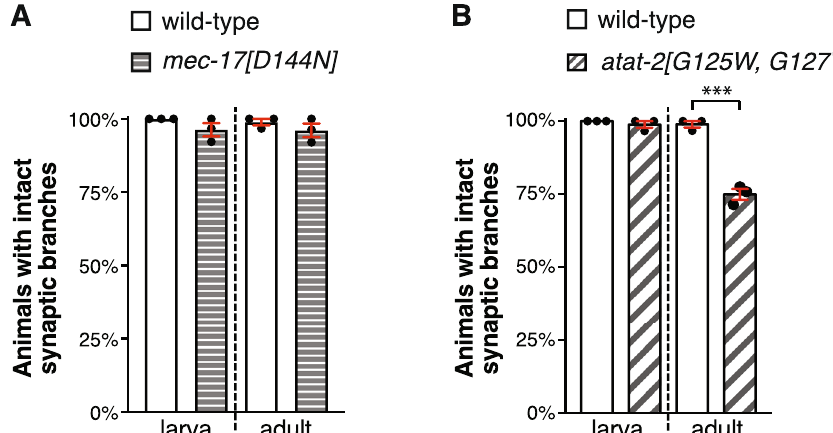
Figure 3. MEC-17 and ATAT-2 function largely independently from their acetyltransferase domains in maintaining synaptic branch stability. ( a ) Quantification of the number of animals with intact synaptic branches in mec-17[D144N] and ( b ) atat-2[G125W, G127W] animals compared to wild-type. Bars show mean ± SE; symbols show the mean of 3-independent experiments, each with n ≥ 21 (total n ≥ 108). *** < 0.001 from t